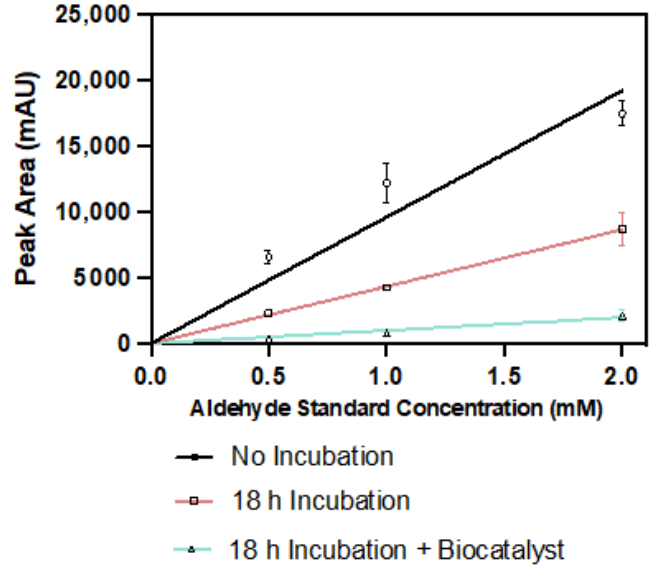
Figure 8. Peak area response of varying concentrations of pyrrole-2-carbaldehyde prepared fresh in 100 mM KPi pH 6.0, 300 mM KHCO 3 , 50 mM Glucose, and 40 mM MgCl 2 , compared to that obtained